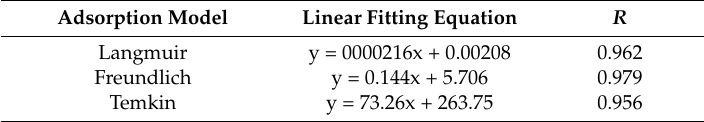
Figure 3. Adsorption of methylene blue (MB) onto GO-COOH sponge. ( a ) Adsorption isotherm. Data represent mean ± SD ( n = 3); ( b ) the Freundlich model; ( c ) the Langmuir model; ( d ) the Temkin model. Table 1. Linear fitting equations of different isothermal adsorption models.